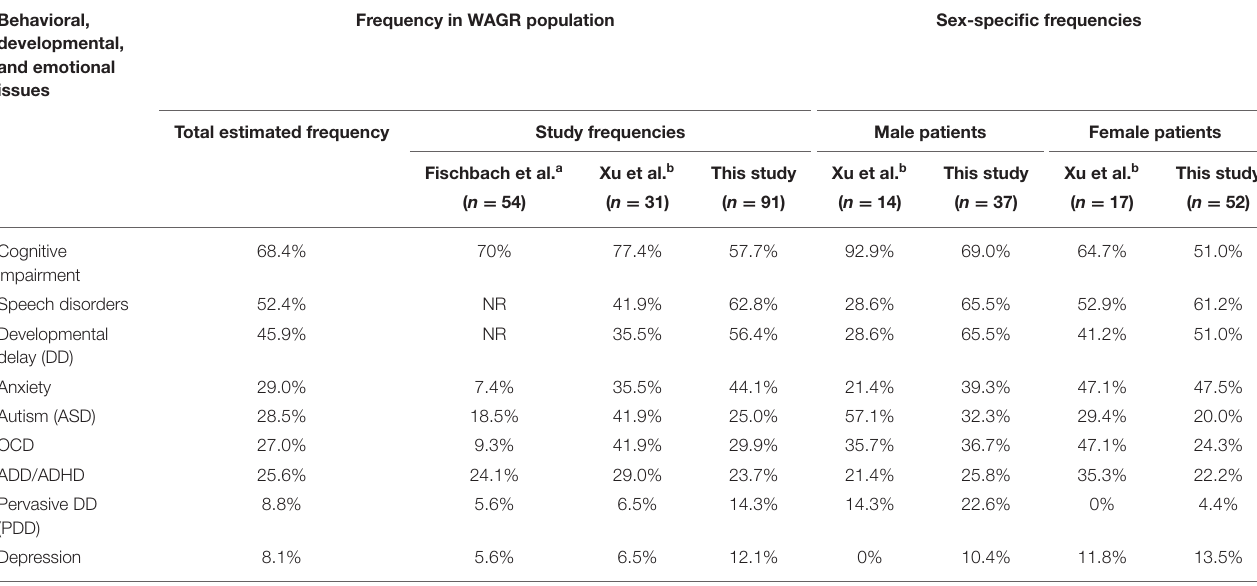
TABLE 4 | Range of behavioral, developmental, and emotional health issues in the WAGR patient population. Behavioral, developmental, and emotional